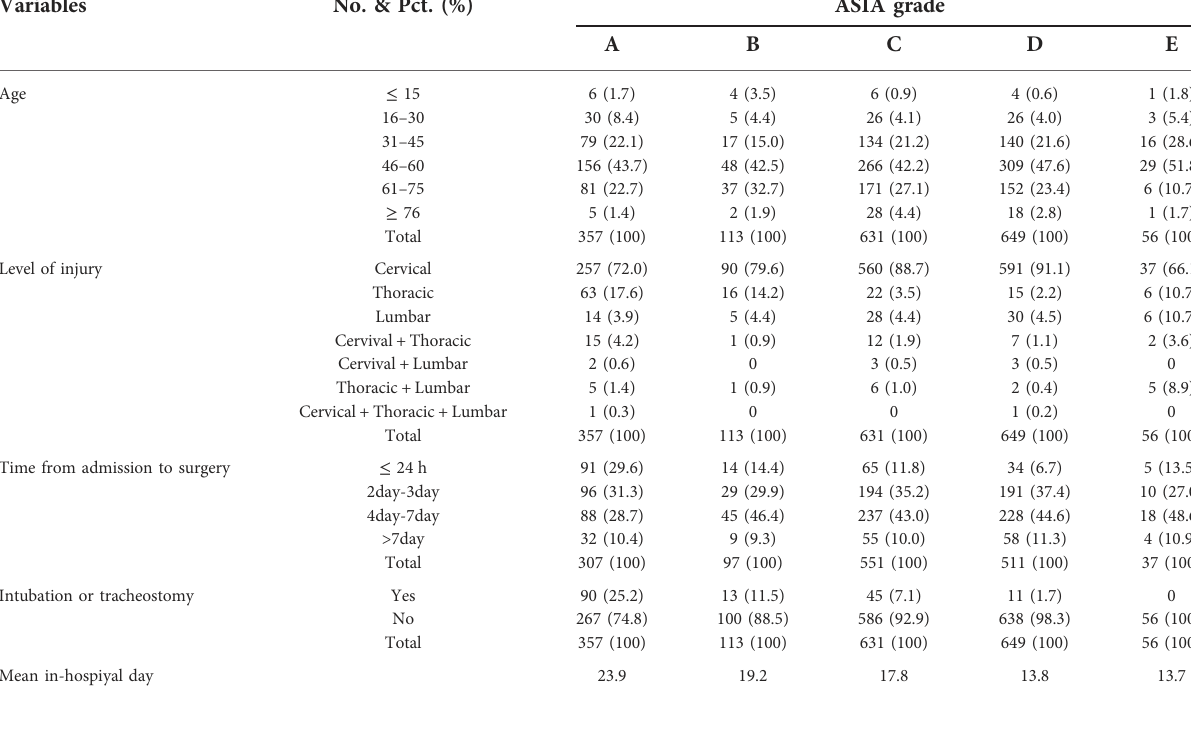
TABLE 4 Characteristics of 1,806 patients with different ASIA grade.